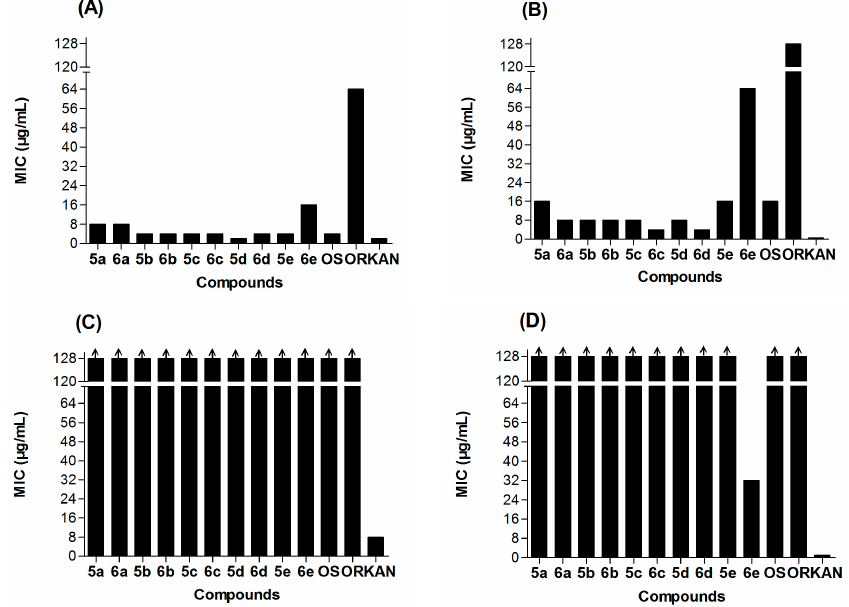
Figure 2. In vitro antibacterial activity of ocotillol-type derivatives against ( A ) B. subtilis 168; ( B ) MRSA USA300; ( C ) P. aer PAO1 and ( D ) A. baum ATCC19606. “ ↑ ”: MIC > 128 µg/mL.